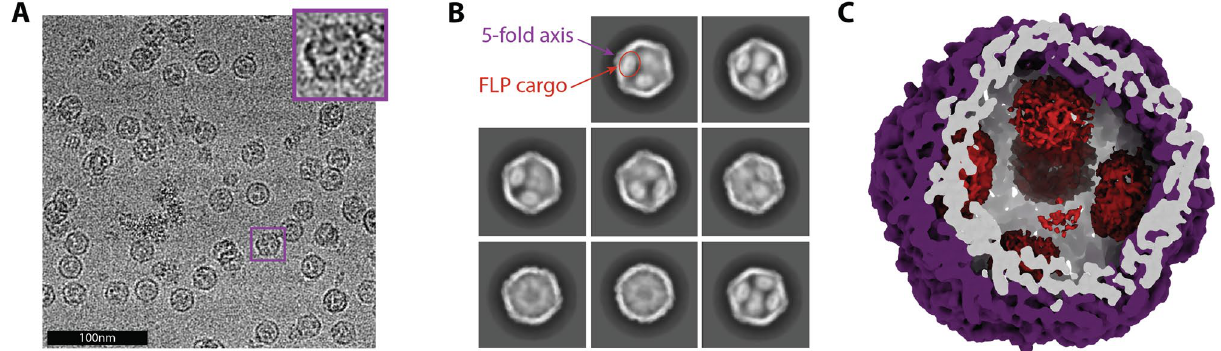
Figure 3. Initial cryo-EM visualization of the FLP-cargo protein within the encapsulin shell. ( A ) Raw micrograph of the FLP-loaded encapsulin. The inset shows an expanded view of a single particle to show that multiple FLP cargo proteins are clearly visible within the encapsulin, even before processing. ( B ) Curated 2D class averages further showing FLP density in some classes and illustrating differences in FLP loading: ~ 2 FLPs per encapsulin (upper-left), 3–4 per encapsulin (bottom-right), as well as a small population lacking any cargo protein (bottom-left). ( C ) Slice through the encapsulin structure showing the shell in purple and weak, noisy FLP densities in red.